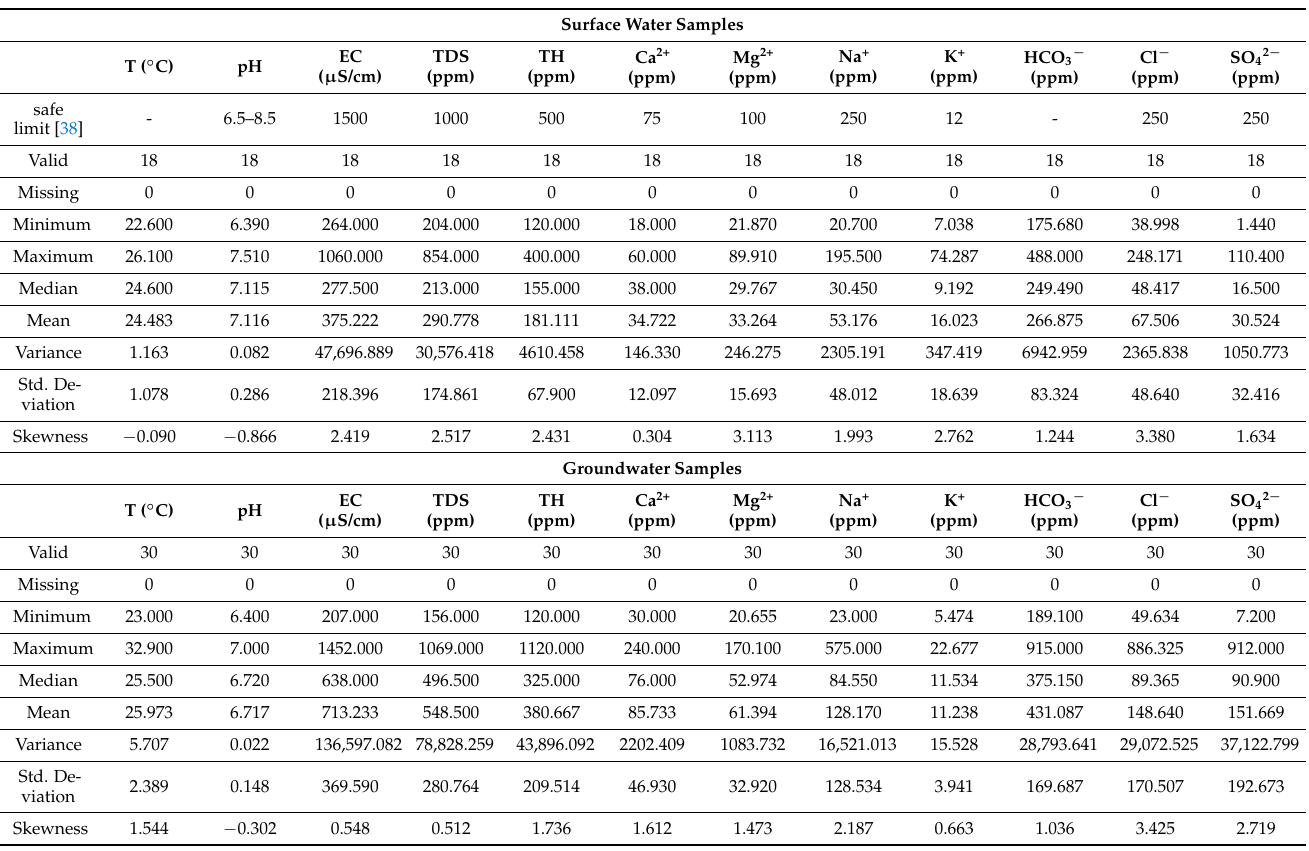
Table 1. Descriptive statistical values for the detected variables in the studied water samples. Surface Water